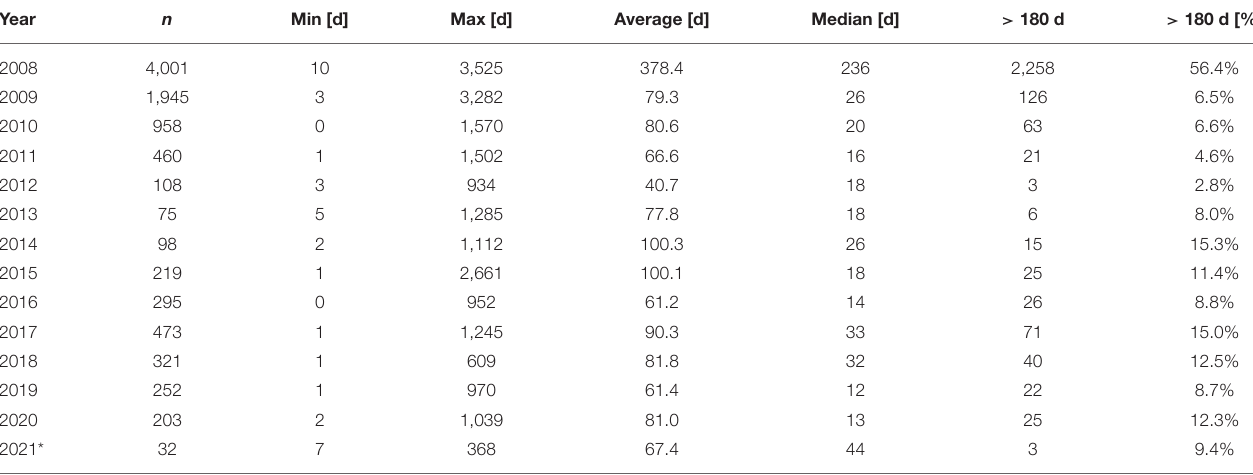
TABLE 2 | Age of the PI animal when it was sampled and sent to the reference laboratory for sequencing.